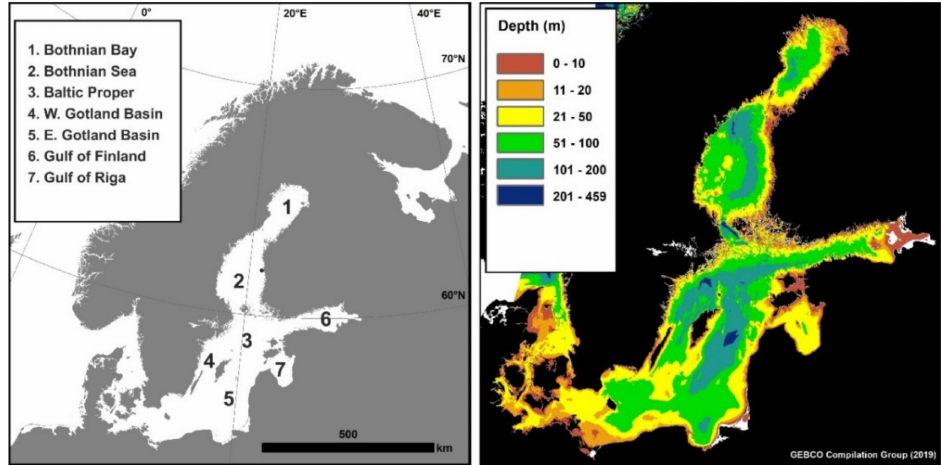
Figure 1. The areal distinction and bathymetry of the Baltic Sea in northern